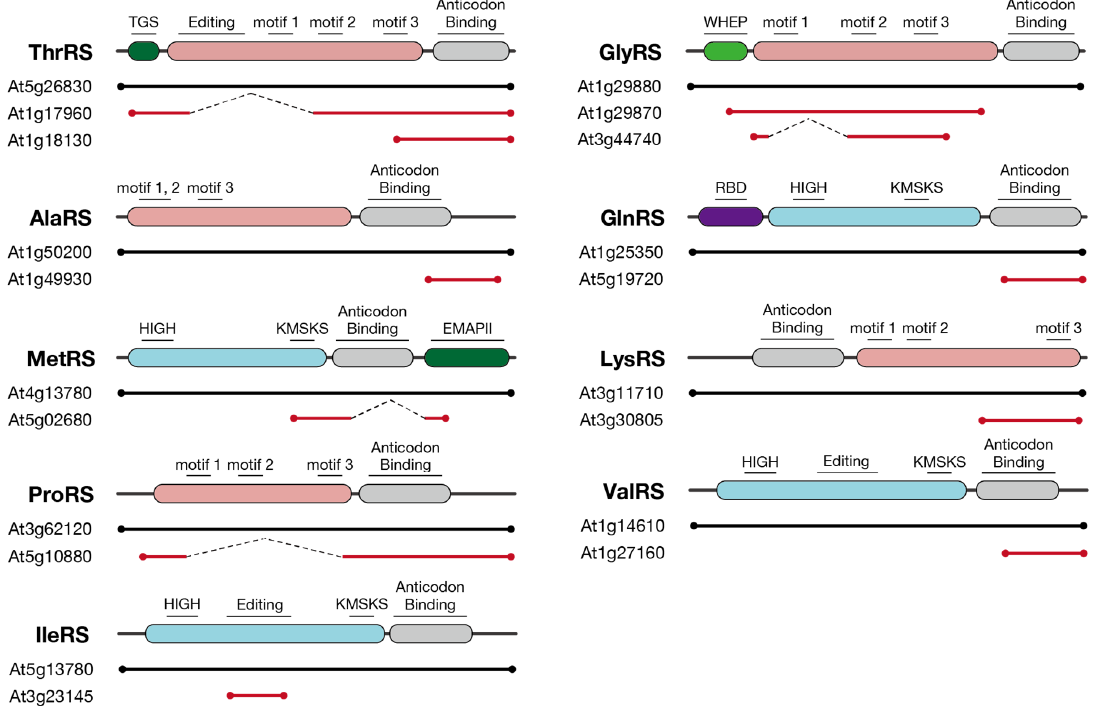
Figure 1. Fragmented sequences of aaRSs found in Arabidopsis genome. Each fragmented sequence (red bar) was compared with a full-length cytoplasmic sequence (black bar) to show the relative position among the full-length sequence.